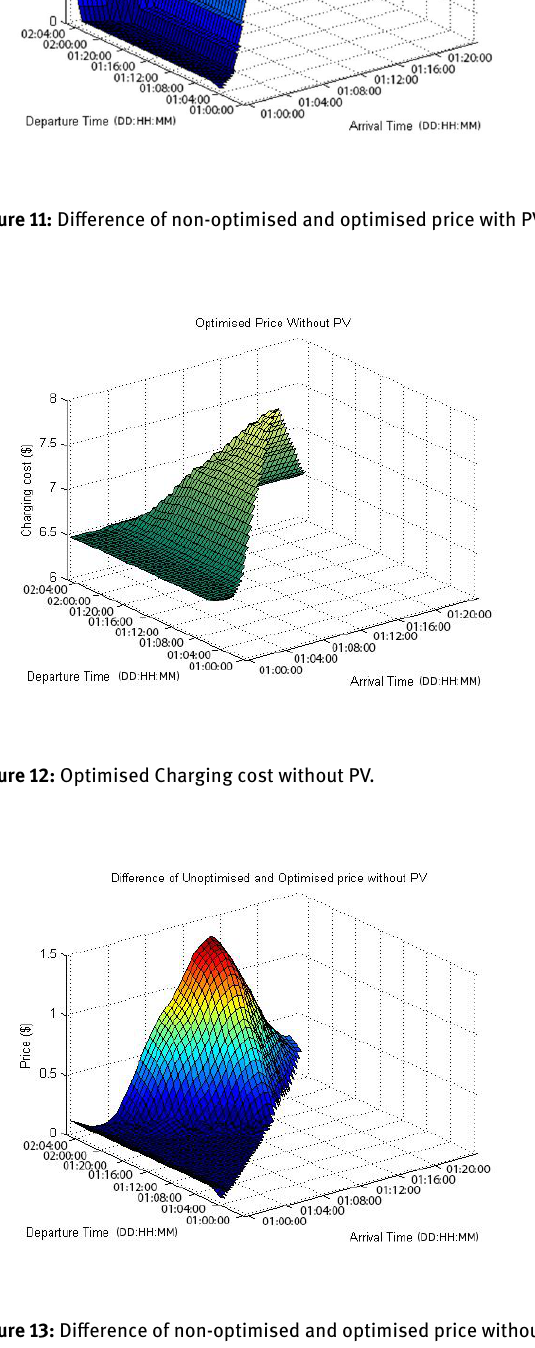
Figure 13: Difference of non-optimised and optimised price without